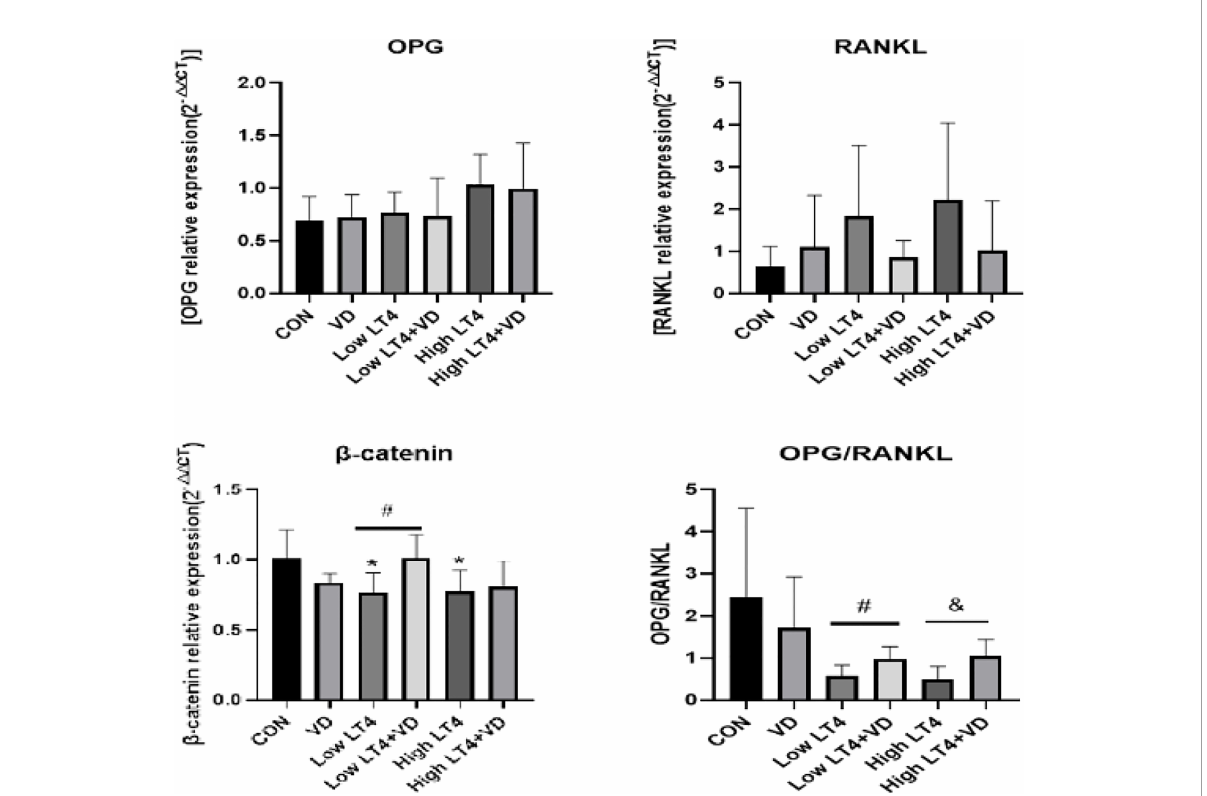
FIGURE 4 Analysis of the OPG/RANKL and Wnt/ b -catenin pathways. Quantitative RT − PCR analysis of OPG, RANKL and b -catenin. The results were calculated based on the DD CT method and normalized to the b -actin mRNA levels. OPG/RANKL ratio compared with that of the CON group, * P < 0.05,. compared with the Low LT4 group, # P < 0.05. Compared with the High LT4 group, & P <